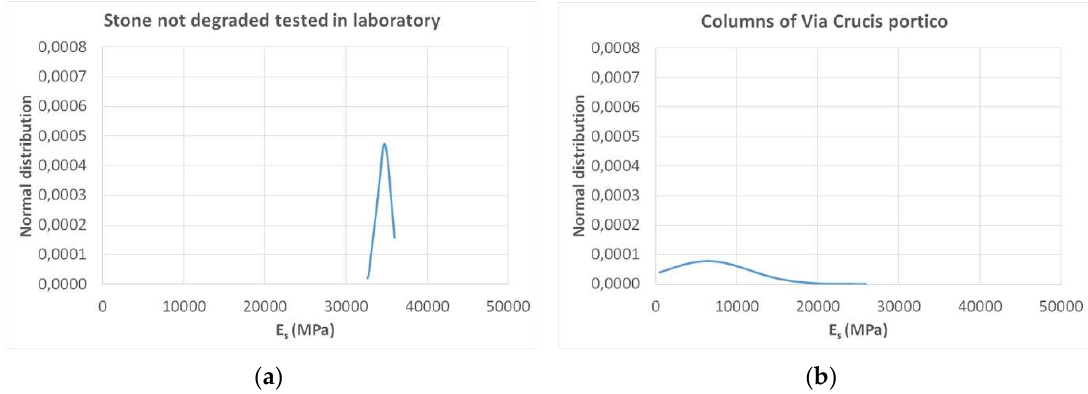
Figure 10. Gaussian distribution E s of non-degraded stone ( a ) and of the same type of stone degraded in the columns of the Via Crucis portico at Ghiffa ( b ).